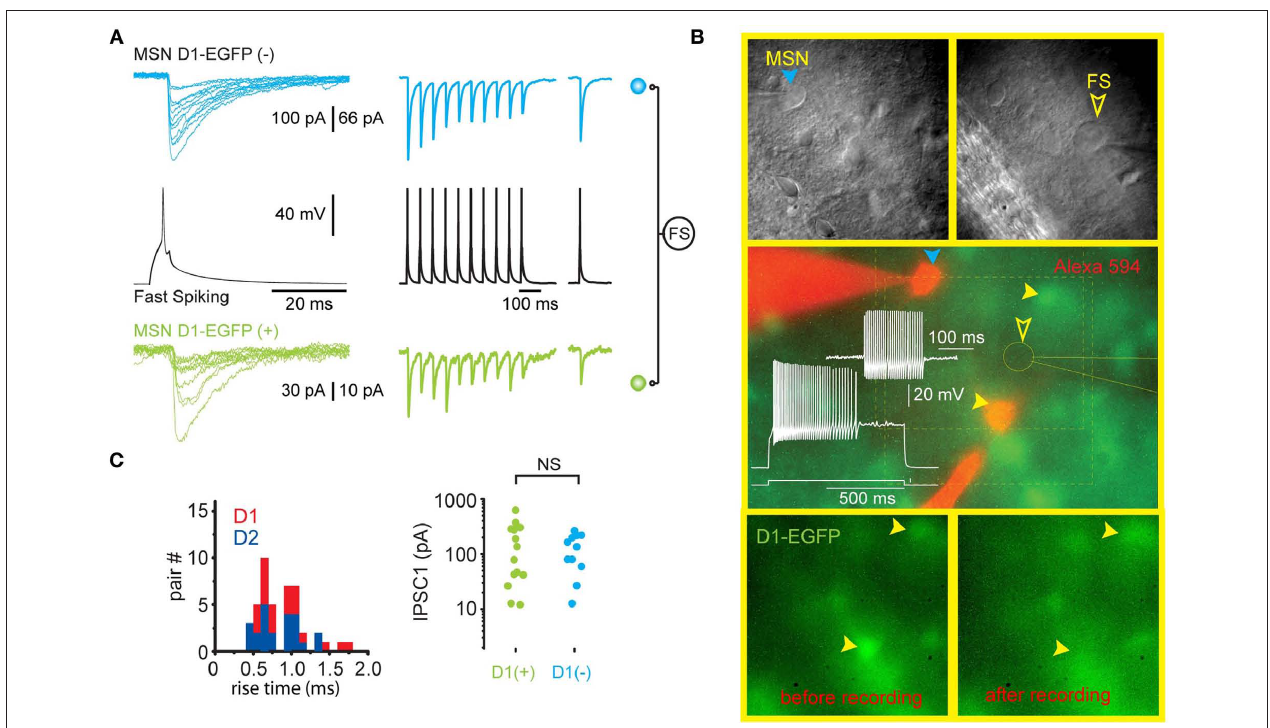
panels show the striatopallidal SPN and FSI and patch pipettes visualized with FiGurE 2 | Single FS interneurons evoke large iPSCs in both direct and DIC. Middle panel shows electrophysiological identification of the FSI. The indirect pathway SPNs. (A) Representative recording from two SPNs that are striatopallidal neuron is recorded and stained with a patch pipette containing postsynaptic to the same FSI (black traces) in a striatal slice from a BAC Alexa 594 (orange). Bottom panels show the disappearance of the EGFP from transgenic D -EGFP mouse. The green traces are from the EGFP-D -expressing 1 1 the striatonigral neuron as a result of dialysis during recording. (C) Summary striatonigral SPN shown in (B) . The blue traces are from another SPN that does data from all triple recordings consisting of one FSI presynaptic to a striatonigral not express EGFP and is therefore a D2-expressing striatopallidal neuron. Note ( n = 14) and striatopallidal ( n = 11) neuron reveals no difference in IPSC rise time similar characteristics (IPSC amplitude, extremely reliable [zero failures] synaptic or amplitude in striatonigral and striatopallidal transmission, short term depression) of each synaptic connection. (B) Upper